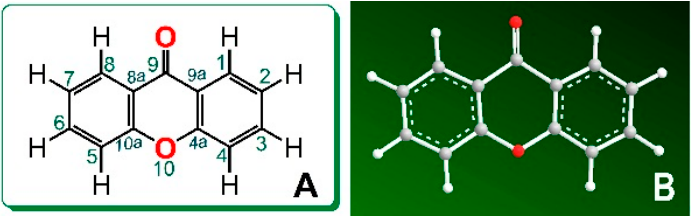
Figure 1. The structure ( A ) and preferential conformation ( B ) of the xanthone scaffold.